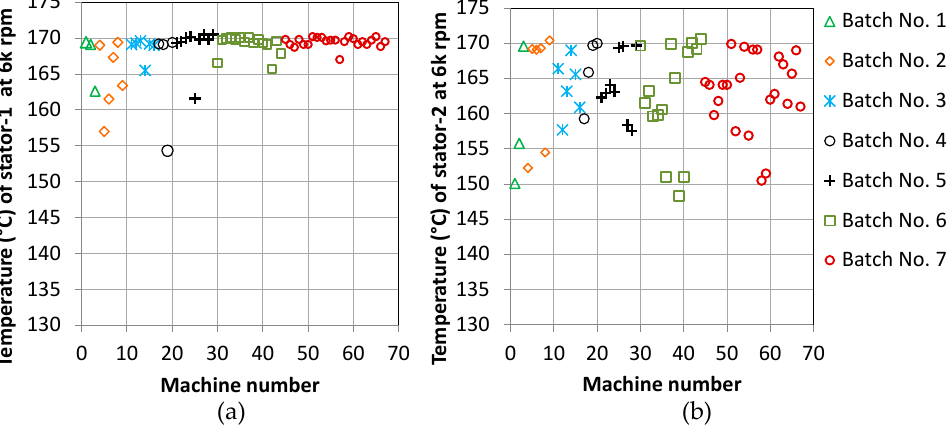
Figure 6. Winding temperature measured for each stator at 6000 rpm for each AFPMSM: ( a ) Stator-1 ( b ) Stator-2.